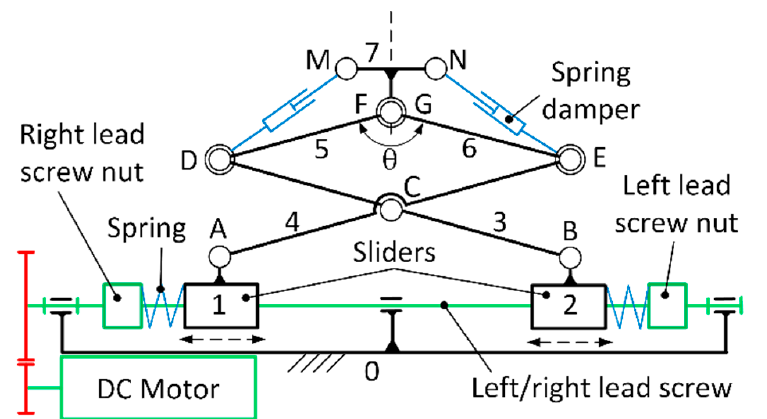
Figure 12. Inspection robot with steering wheels.